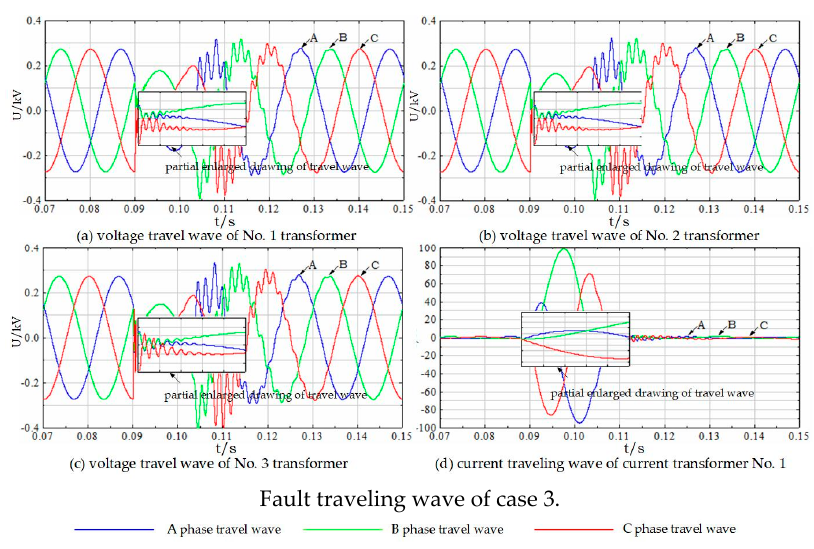
Figure 8. Waves of current and voltage in different conditions.